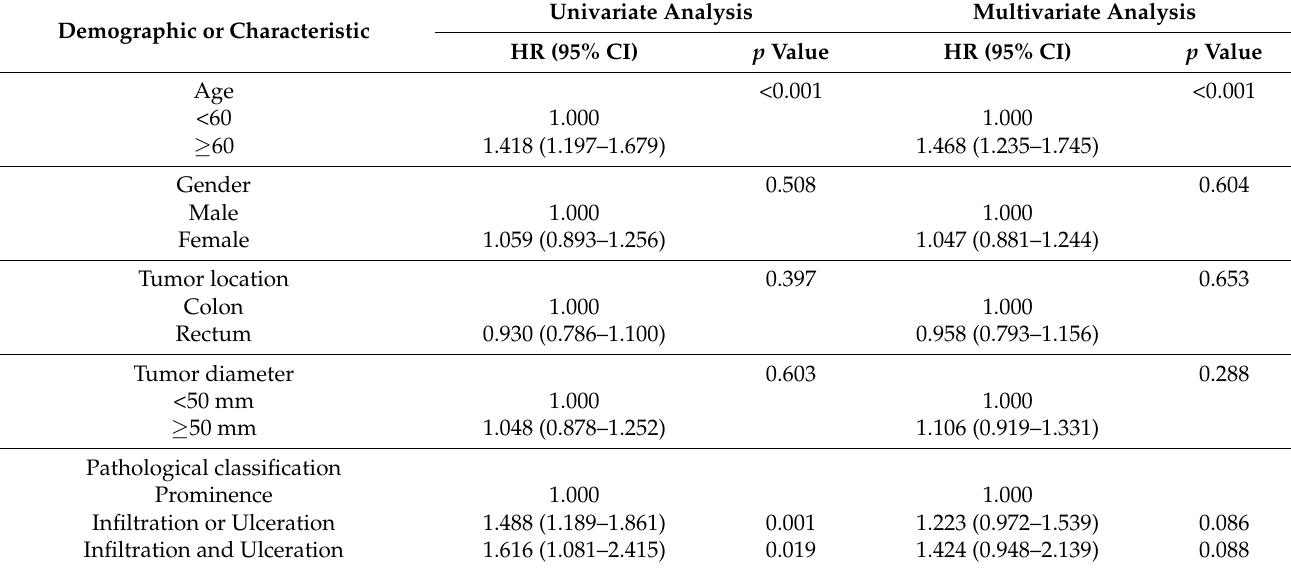
Table 4. Association between predictive factors and overall survival of CRC in the validation